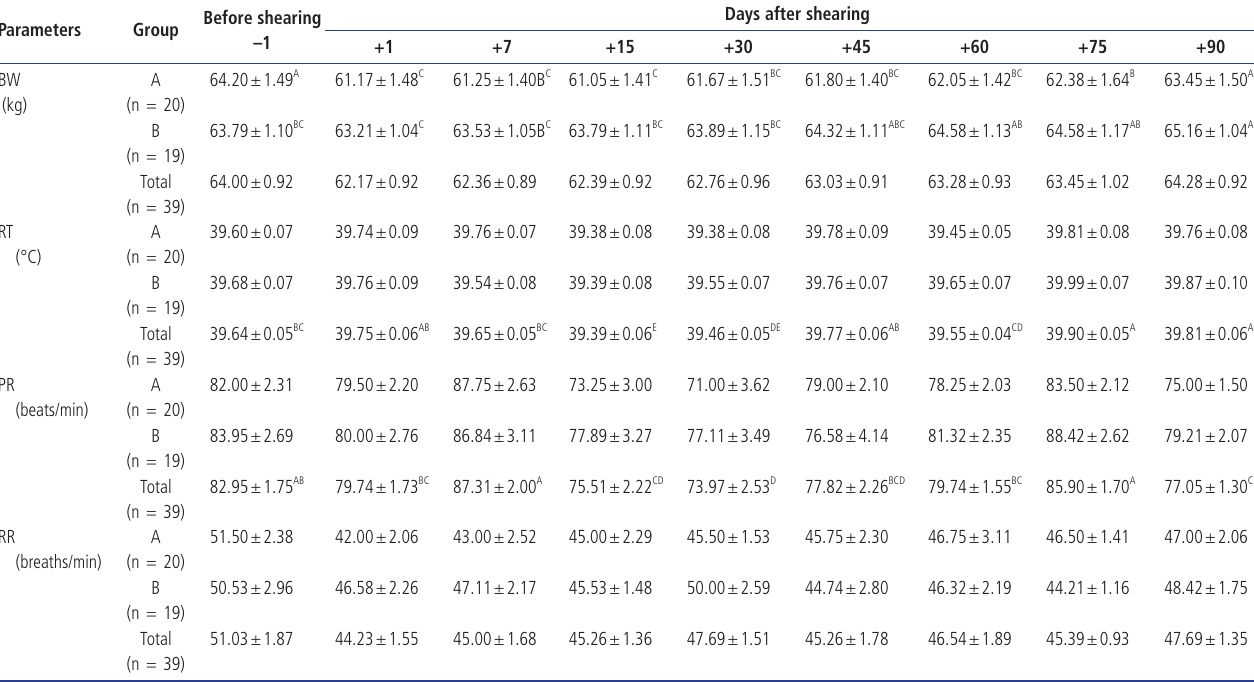
Table 2. Average values (±standard error) of body weight, rectal temperature, pulse rate, and respiratory rate in the groups during the experiment Before shearing Parameters Group